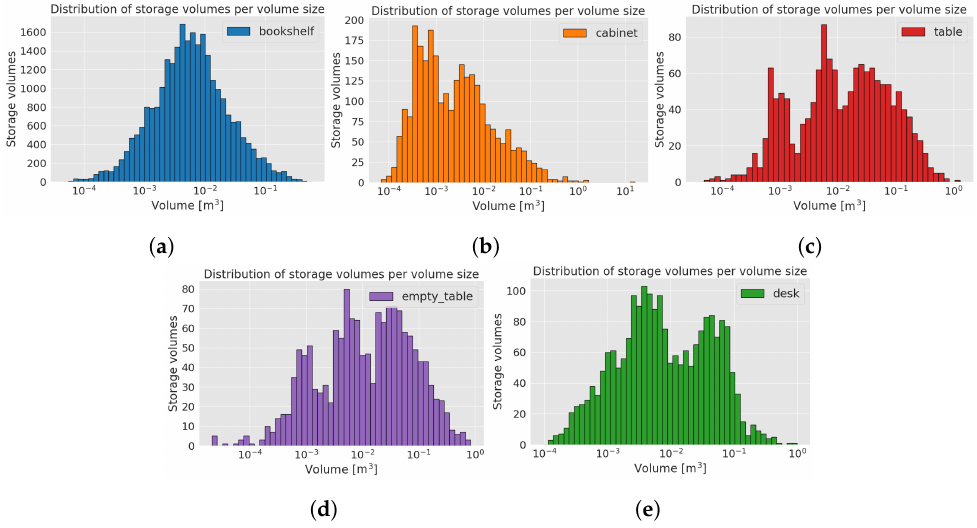
Figure 10. Storage volume per volume size for each furniture class: ( a ) bookshelf, ( b ) cabinet, ( c ) table, ( d ) empty table, and ( e )